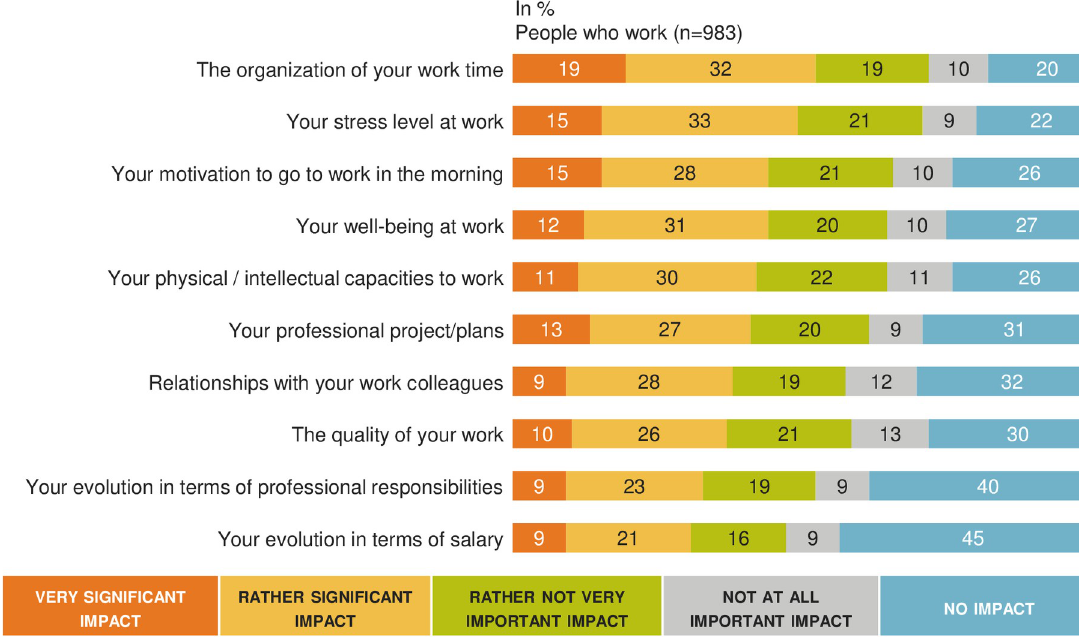
Fig 6. MAR burden in professional life: A French national survey. Percentage of answers to the question “Personally, do you feel that MAR has had a very significant, rather significant, rather not very important, not at all important impact or no impact on”” (n = 983).